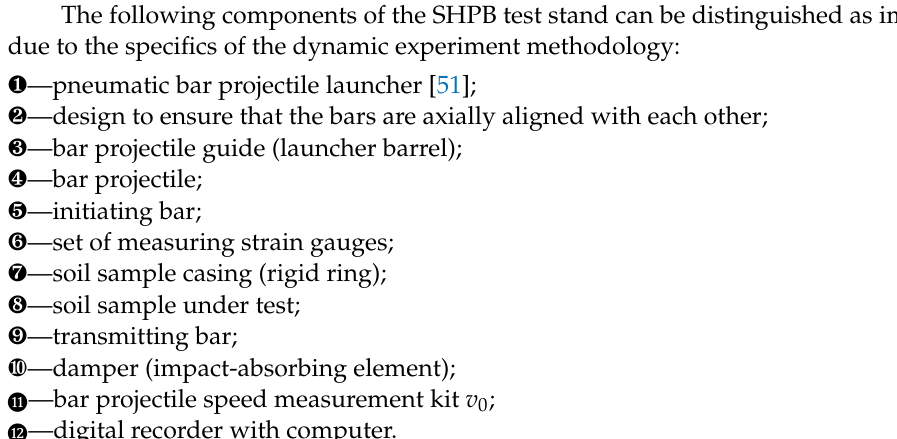
Figure 7. View of the Be tt ersizer S3 Plus laser particle size analyzer test stand located in the Depart- Figure 6. View of the SHPB test stand located in the Department of Military Engineering and Infra- ment of Military Engineering and Infrastructure of the MUT, with markings of crucial components ① – structure of the MUT, with markings of crucial components ❶ – ⓬ .